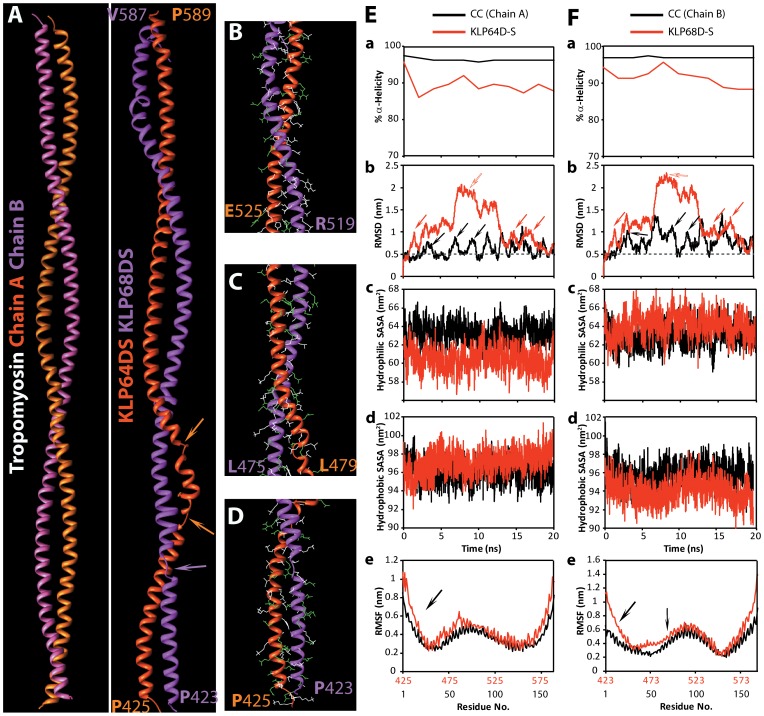
An atomic resolution model depicting stability and interactions between the KLP64D and KLP68D stalk polypeptides in a heterodimer.A) Ribbon structures of Tropomyosin Coiled-Coil homodimer (Chain A shown in dull orange and Chain B in hot pink) and KLP64D/68D-S heterodimer model (KLP64DS in orange red and KLP68DS in magenta) after 20 ns MD simulations at 300K. B–D) The backbone structures of the KLP64DS and KLP68DS the heterodimer model with the amino acid residues (blue and green) predicted to form atomic contacts in the C-terminal (B), middle (C) and N-terminal (D) regions. Amino acids with hydrophobic and charged side chains are marked in white and green, respectively (Table S4). E) Time evolution of % α-helicity (a), RMSD (b), hydrophilic-SASA (c), hydrophobic-SASA (d), and RMSF (Cα) as a function of residue number (e), respectively, of the tropomyosin (CC, chain A) and KLP64D at 300K (27°C). F) A similar time evolution of the same set of measurements as shown in E is also shown for a tropomyosin (CC, chainB) and KLP68D.